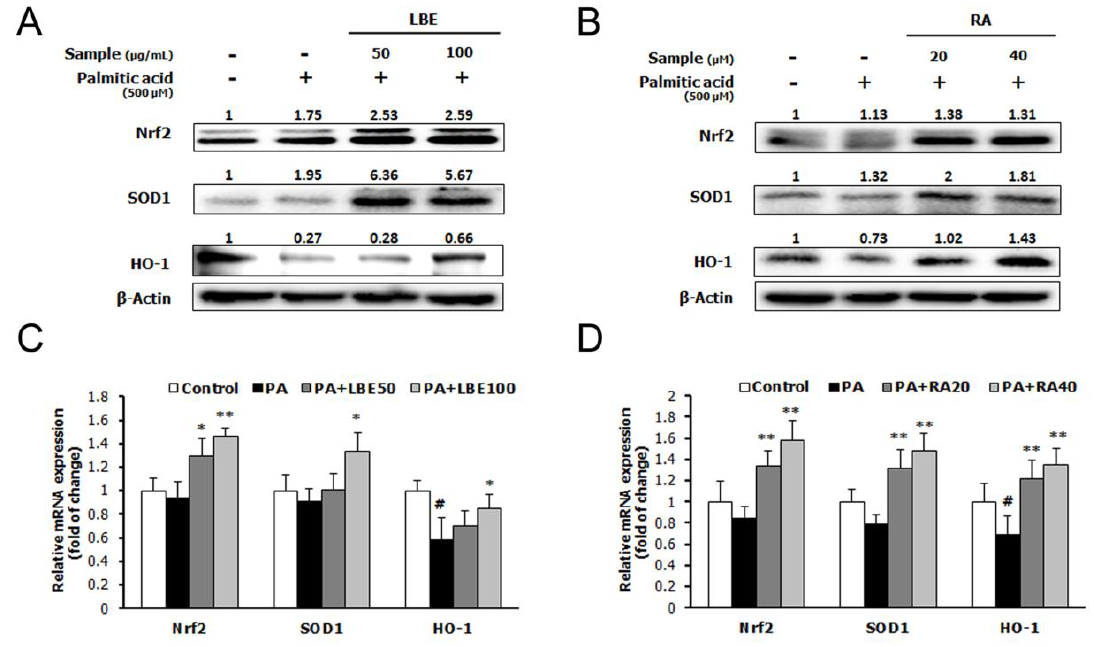
Figure 4. E ff ects of LBE and RA on the expression of antioxidative stress genes and proteins in HepG2 cells incubated with LBE or RA for 24 h with or without PA. Protein levels of nuclear factor erythroid 2-related factor 2 (NRF2), superoxide dismutase 1 (SOD1), and heme oxygenase 1 (HO-1) with ( A ) LBE and ( B ) RA. mRNA levels of the genes encoding NRF2, SOD1, and HO-1 with ( C ) LBE and ( D ) RA. β -Actin was used as an internal control for western blotting and qPCR analysis. Results are expressed as the mean ± SD of three independent experiments. # p < 0.05 compared with the control group; * p < 0.05 and ** p < 0.01 compared with the PA-treated cells.